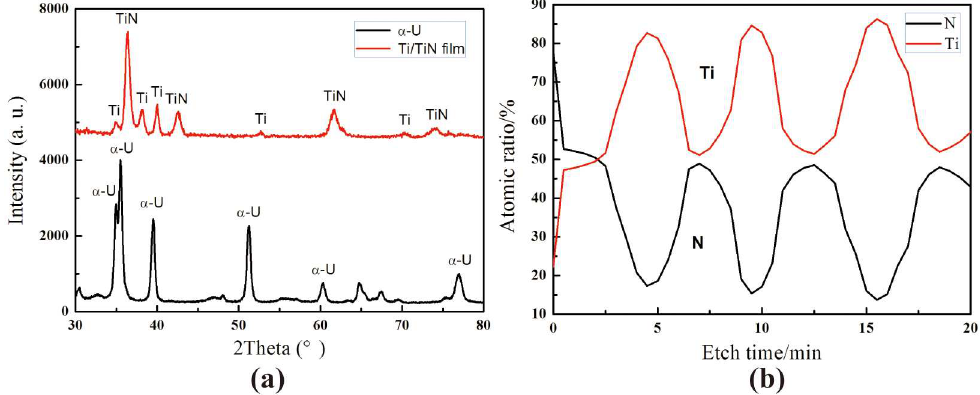
Fig 3. XRD patterns (a) and element depth distribution (b) of Ti/TiN multilayer